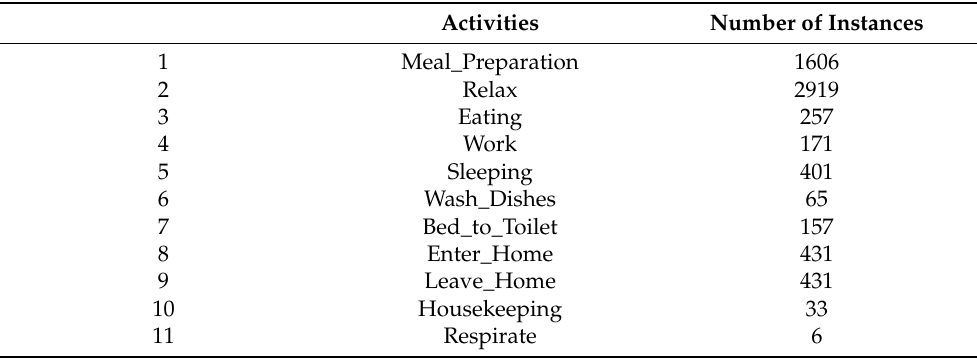
Table 2. Number of Instances for